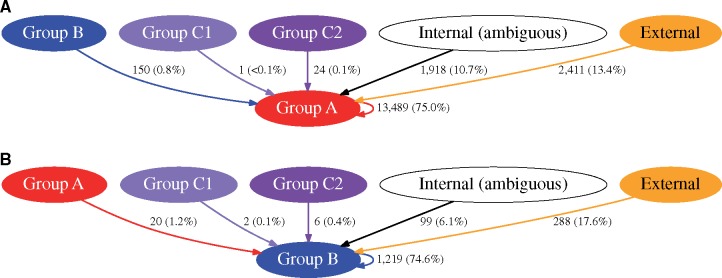
—Core genome recombination between the major groups of Pseudomonas aeruginosa. The inferred sources of recombinant regions identified within isolates in Group A (panel A) and Group B (panel B) are shown. The vectors indicate the direction of recombinant region flow. “Internal (ambiguous)” represents a source of recombinant sequence within Groups A, B, C1, or C2 but for which the source could not be attributed to any one of the groups. “External” represents a source of recombination from outside of Groups A, B, C1, or C2. Vectors are labeled with the number of recombination events originating from each source, and the numbers in parentheses are the percentages of the total recombination events in the destination group represented by each vector.